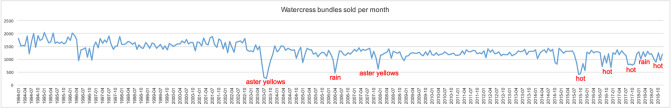
Monthly harvest of watercress in “bundles” from 1994–2018.Reasons hypothesized by the Sumida family to have caused lower watercress yields are shown in text under the bundles sold per month graph.